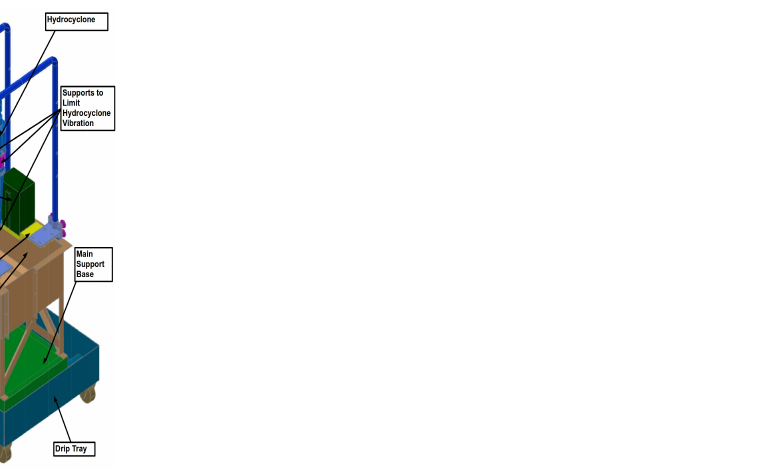
Figure 1. Experimental setup (adapted from an image courtesy of Multotec Pty Ltd., Johannesburg, South Africa) [24]. Table 1. Feed, overflow, and underflow mass flow rates as well as feed mass fractions.